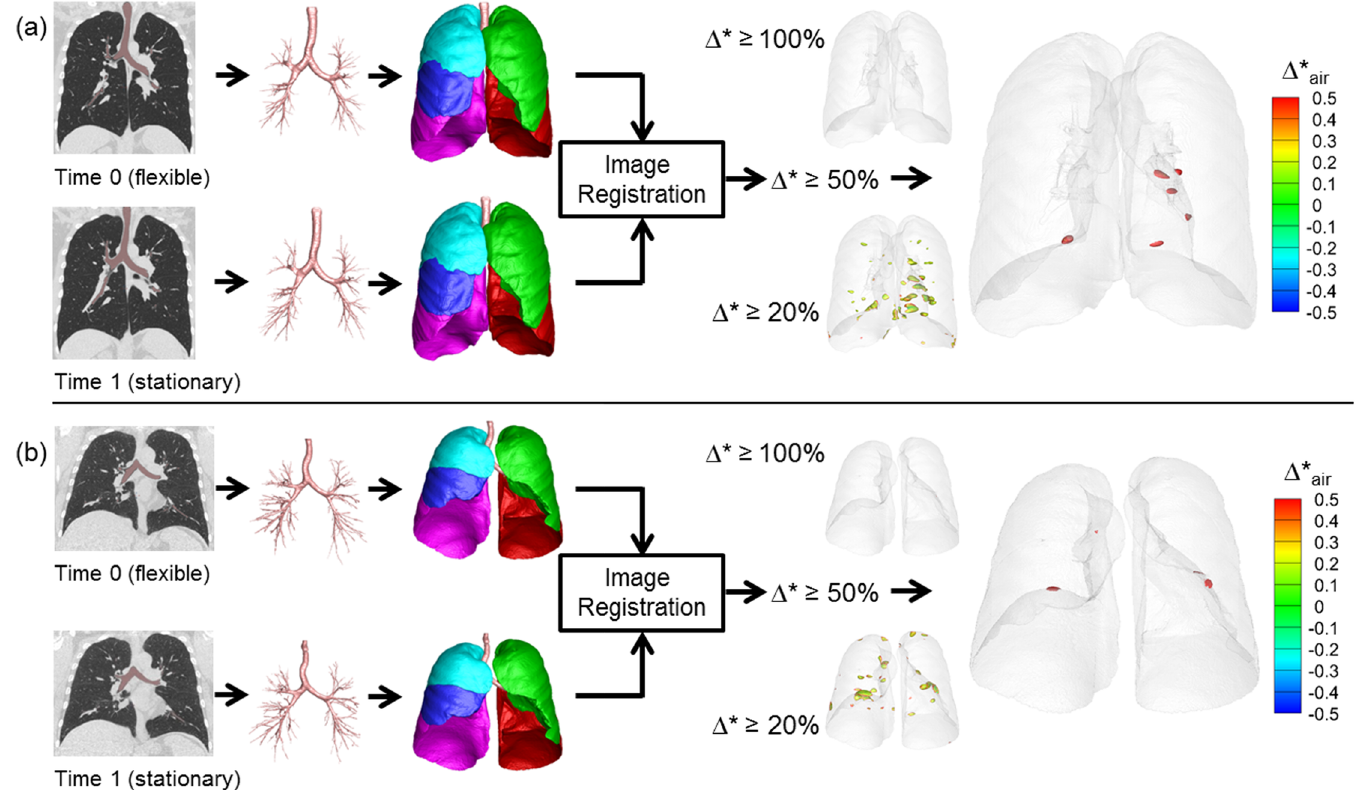
Fig 3. Regional hyper-expansion signals in serial CT pairs of two control subjects. (a) Normal non-smoker(Group 1) and (b) Normal smoker (Group 2).